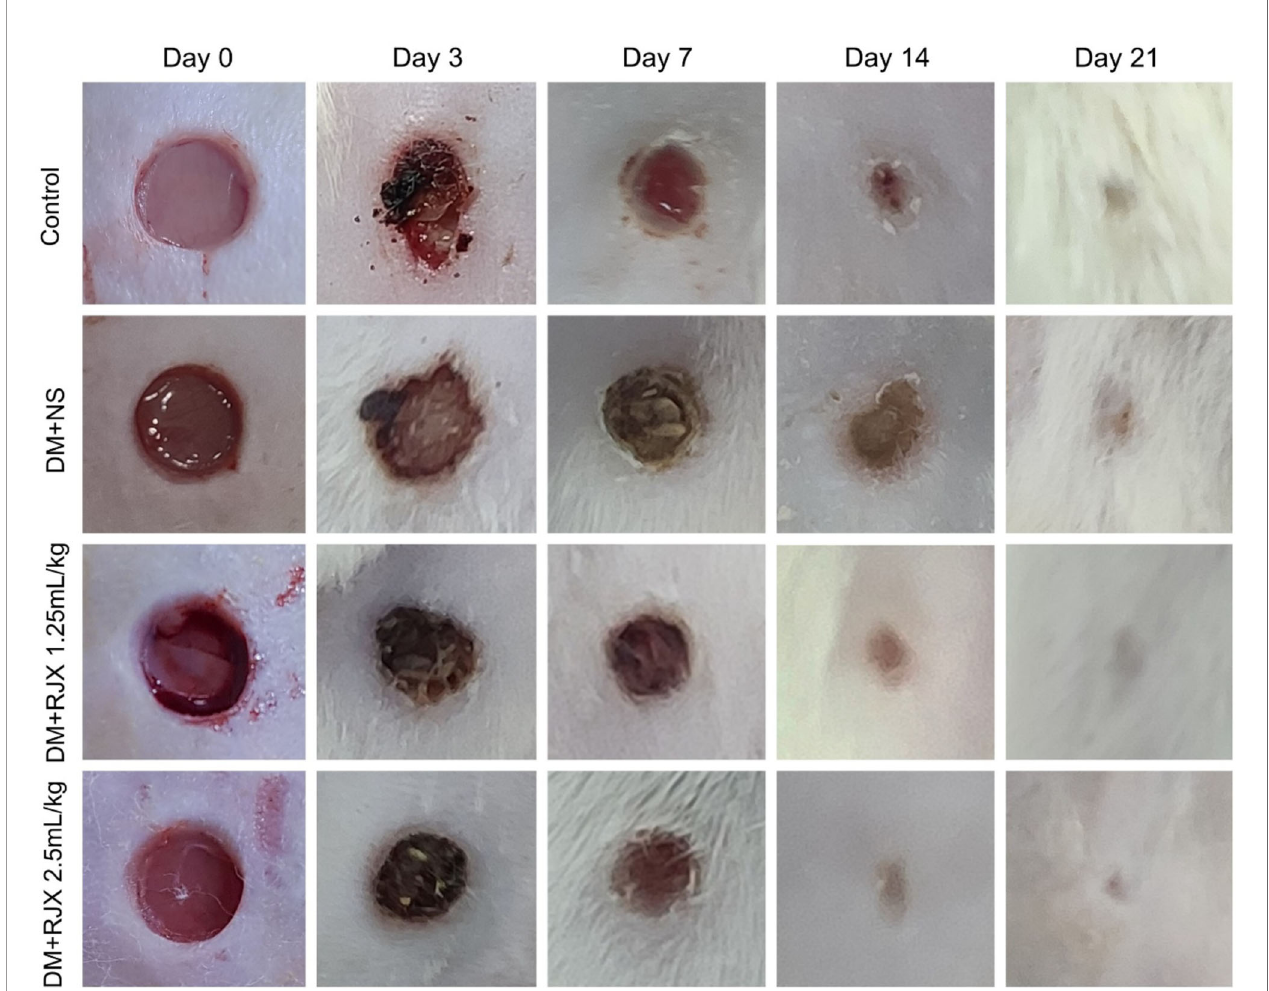
FIGURE 2 | Effects of RJX on Cutaneous Wound Healing in Diabetic, Obese Rats. Representative wound bed images from rats in Figure 1. Healing of the wounds was signi fi cantly delayed in diabetic rats treated with NS compared to untreated non-diabetic control rats. Except for untreated control rats (Control), each rat was fed a high-fat diet (HFD) for 4 weeks and injected a single dose of streptozotocin (STZ, 45 mg/kg i.p.) to induce diabetes (DM). At the end of 4 weeks, an experimental wound with a diameter of 5 mm (initial wound areas=19.625 mm 2 ) was formed in all rats. The macroscopic changes of the wound area were documented using a digital